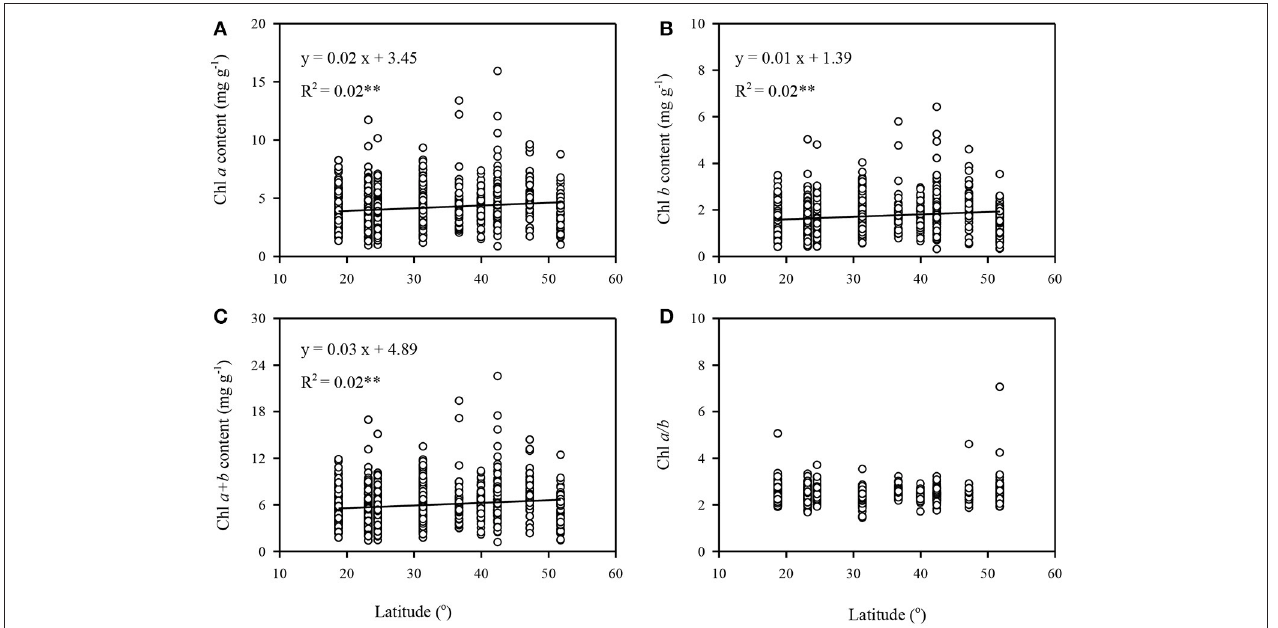
FIGURE 3 | Latitudinal trends of leaf chlorophyll traits in the forests of China. (A–D) were calculated in Chl a , Chl b , Chl a + b , Chl a/ b , respectively. Only significant regression ( P < 0.05) being given. ** P < 0.01.